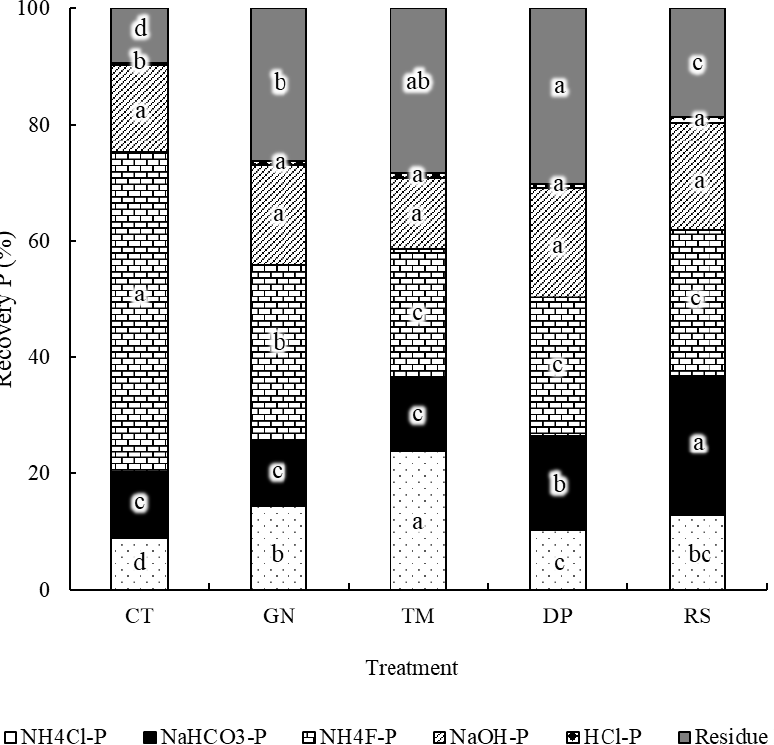
Figure 2. The proportions of phosphorus (%) in a tropical sandy soil as influenced by the incorpora- tion of organic residues of contrasting quality including control soil (CT), groundnut stover-treated soil (GN), tamarind leaf litter-treated soil (TM), dipterocarp leaf litter-treated soil (DP), and rice straw-treated soil (RS). Significant differences within a P fraction among treatments are indicated by different letters (a, b, c, d) at p < 0.05.